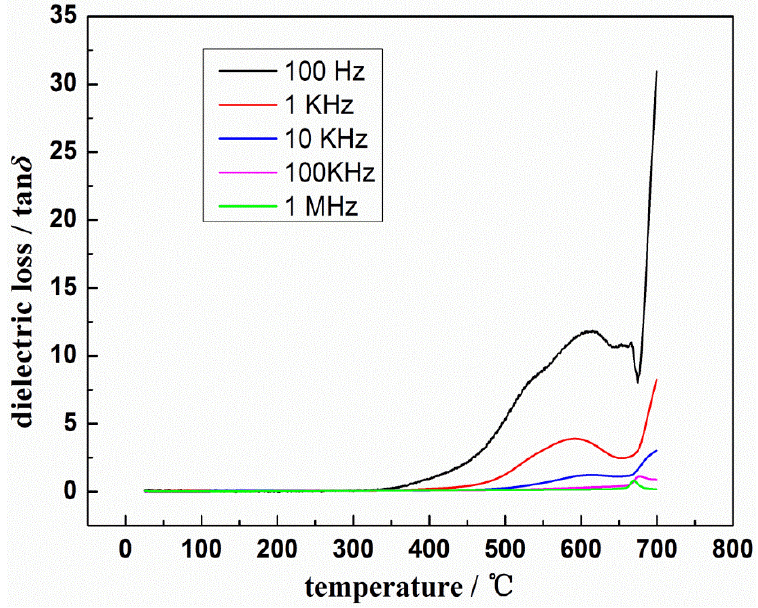
Figure 4. Temperature dependent tanδ at different frequencies of La 0.9 Sr 0.1 TiO 3+δ